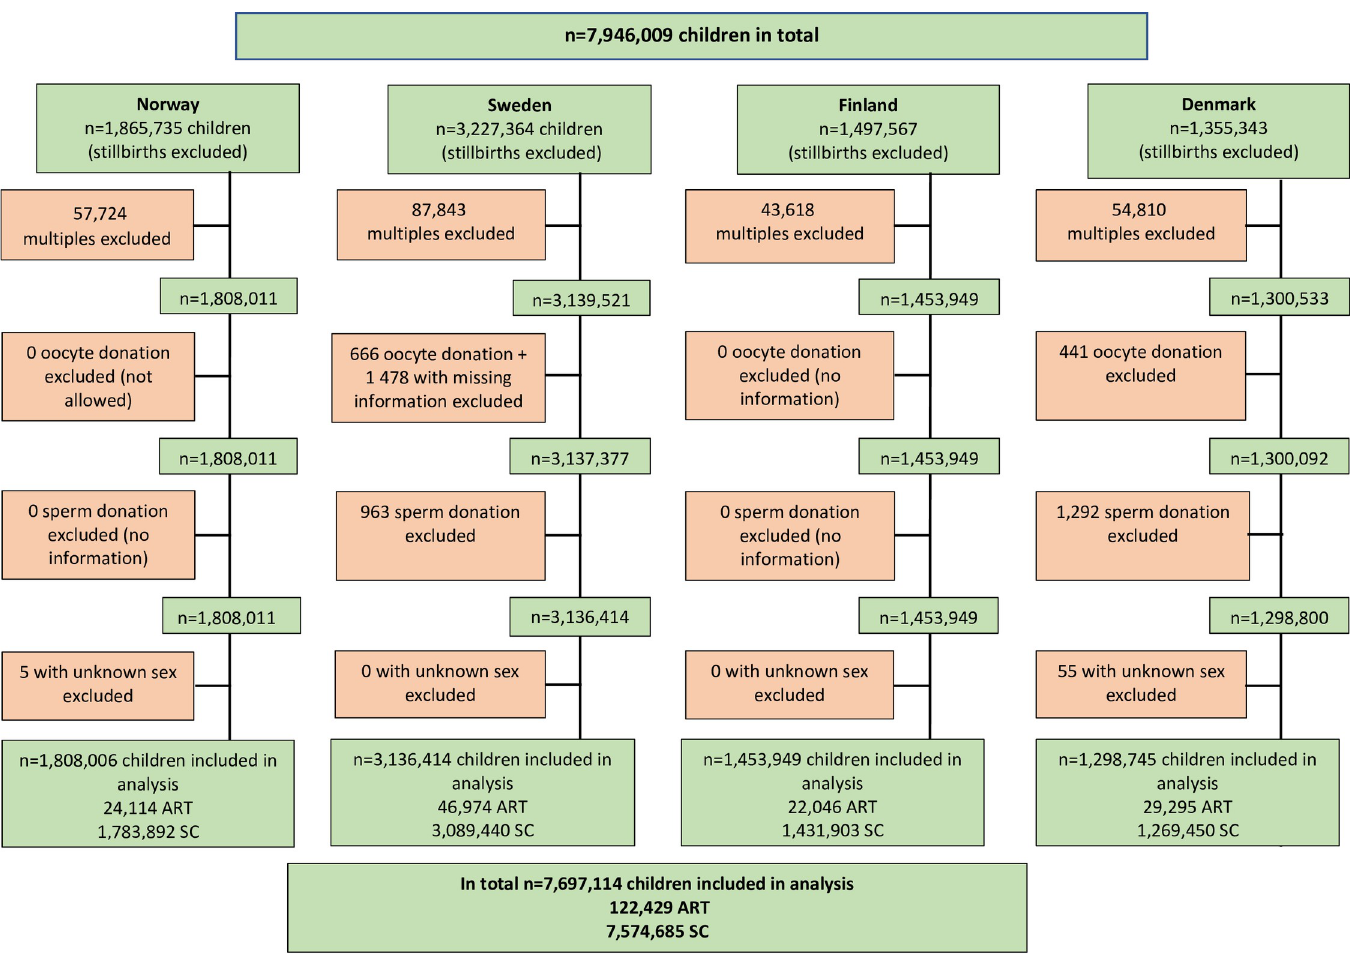
Fig 1. Flowchart of children included in the study. ART, assisted reproductive technology; SC, spontaneous